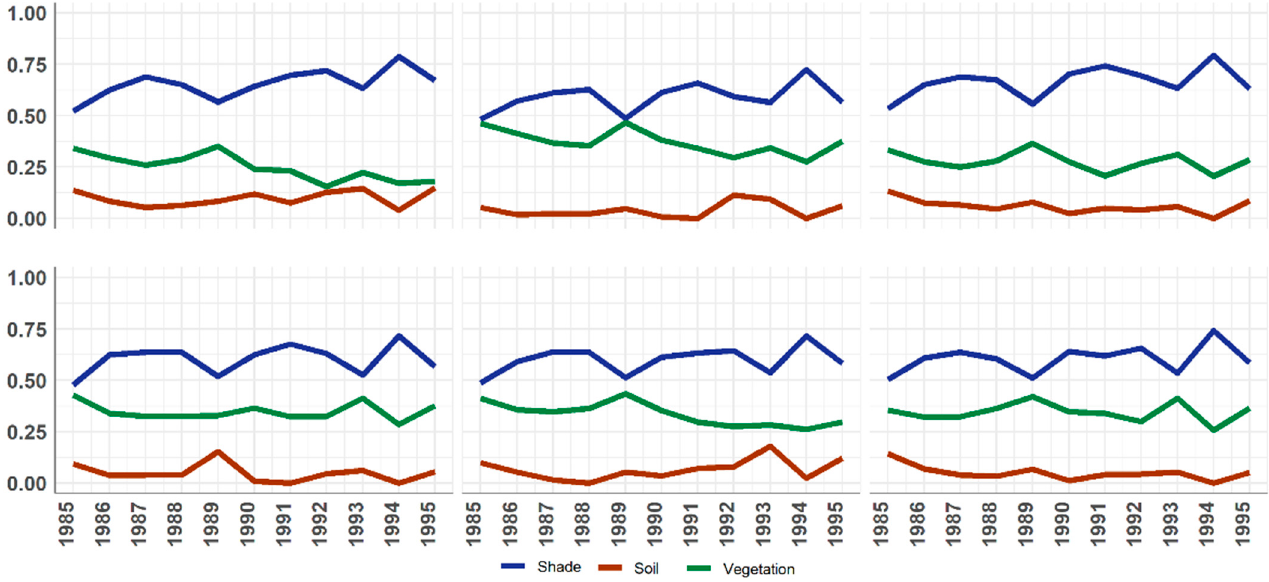
Figure 13. Phenological assessment of eucalypt plantation during the 1985–1995 period based on the fraction-image time series and forest plantation rotation for six samples ( A – F ), as shown in Figure 2.